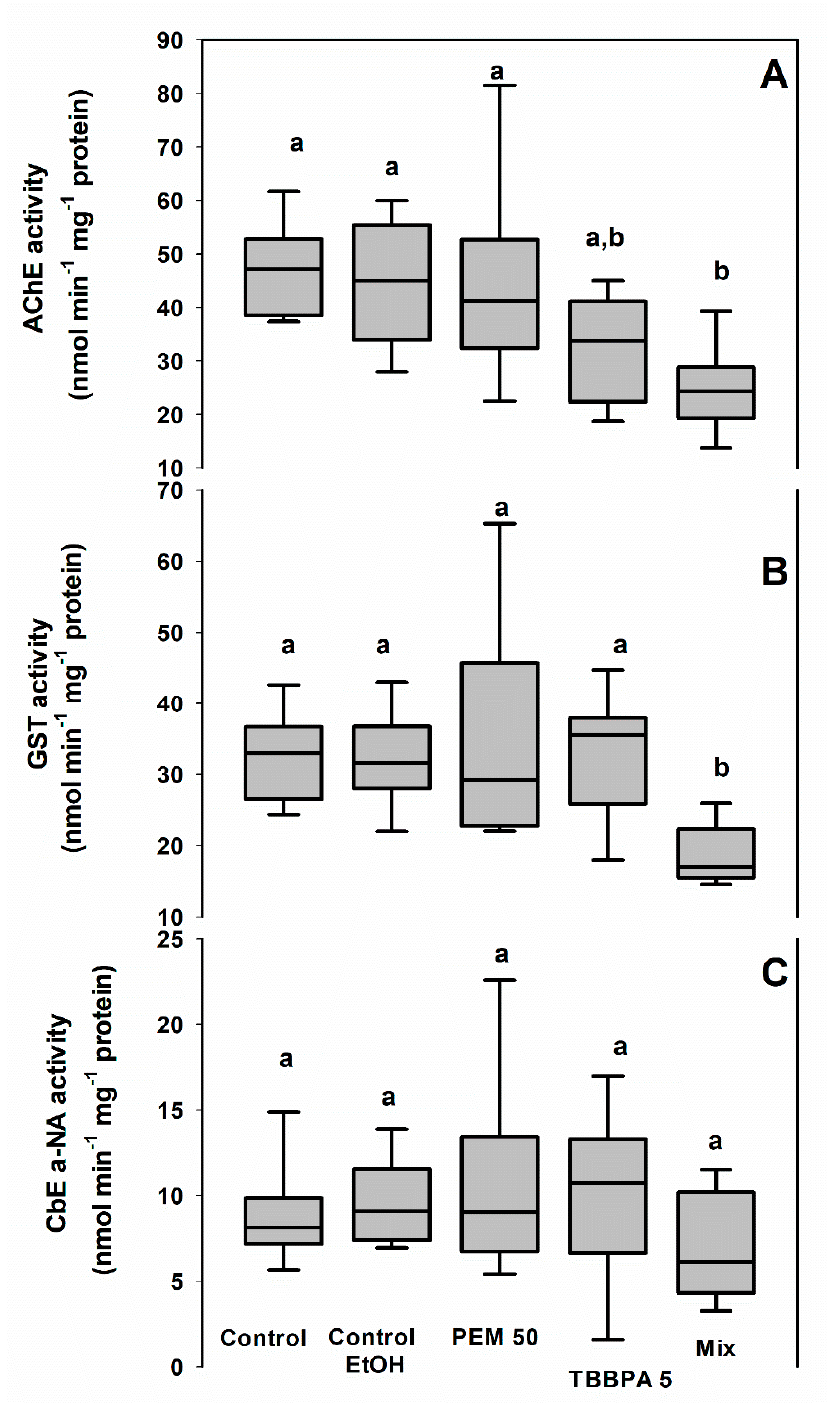
Figure 1. Variation of ( A ) acetylcholinesterase (AChE), ( B ) glutathione S-transferase (GST), and ( C ) carboxylesterase 1-naphthyl acetate (1-NA) activities in shrimp whole body after 96 h of exposure to the following different experimental groups (n = 10 for each aquarium): Control, Control-EtOH, PEM 50 (polyethylene microplastics, 50 µg L − 1 ), TBBPA 5 (TBBPA, 5 µg L − 1 ), and Mix group (mixture of 50 µg L − 1 polyethylene microplastics and 5 µg L − 1 TBBPA). Tukey box plots indicate the median, the 25th and 75th percentiles (box edges), and the range (whiskers). Different lowercase letters denote significant differences among experimental groups ( p < 0.05, Kruskal–Wallis H test, followed by a posteriori multiple comparisons of mean ranks for all groups).